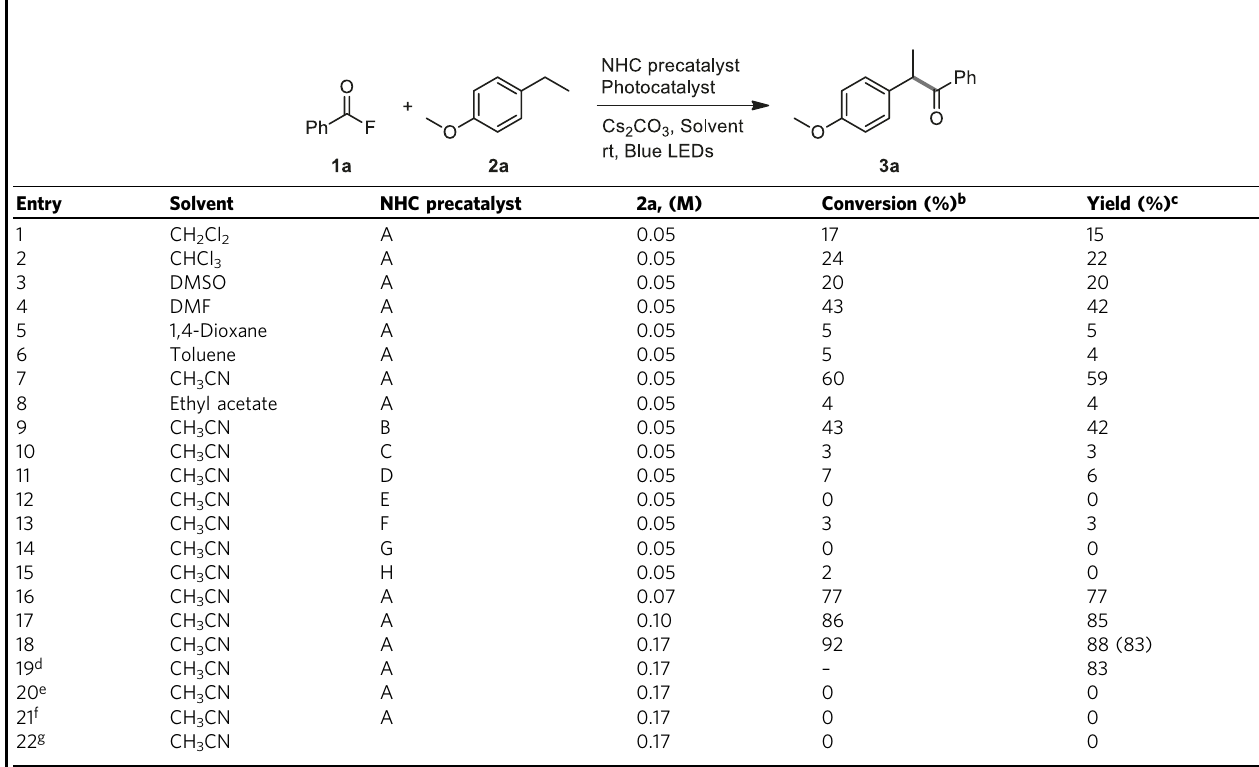
a Reaction conditions: unless otherwise noted, all the reactions were carried out with benzoyl fl uoride (0.4mmol), 4-ethyl anisole (0.1mmol), NHC catalyst (0.02mmol), Cs 2 CO 3 (0.2mmol), and [Ir(dF (CF 3 )ppy) 2 (dtbbpy)]PF 6 (0.002mmol) in anhydrous CH 3 CN (2mL), irradiation with blue LEDs at room temperature for 24h. b GC-FID conversion using 1,3,5-trimethoxybenzene as an internal standard. c1 H NMR yield using 1,3,5-trimethoxybenzene as an internal standard and yield of isolated product is given in parentheses. d 4CzIPN (0.002mmol) was used instead of [Ir(dF(CF 3 )ppy) 2 (dtbbpy)]PF 6 as the photocatalyst. e The reaction was carried out in the dark. f No photocatalyst was added.